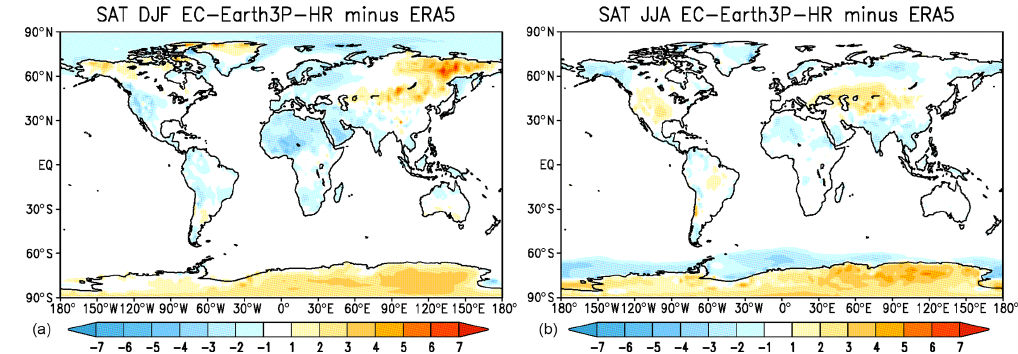
Figure 6. SAT: bias ( ◦ C) of EC-Earth3P-HR with respect to ERA5 for the period 1979–2014: (a) DJF and (b) JJA. Global means of SAT for EC-Earth3P-HR are 11.01 (DJF) and 15.85 (JJA), and for ERA5 12.43 (DJF) and 15.95 (JJA). RMSEs of EC-Earth3P-HR with respect to ERA5 are 1.25 (DJF) and 1.06 (JJA).